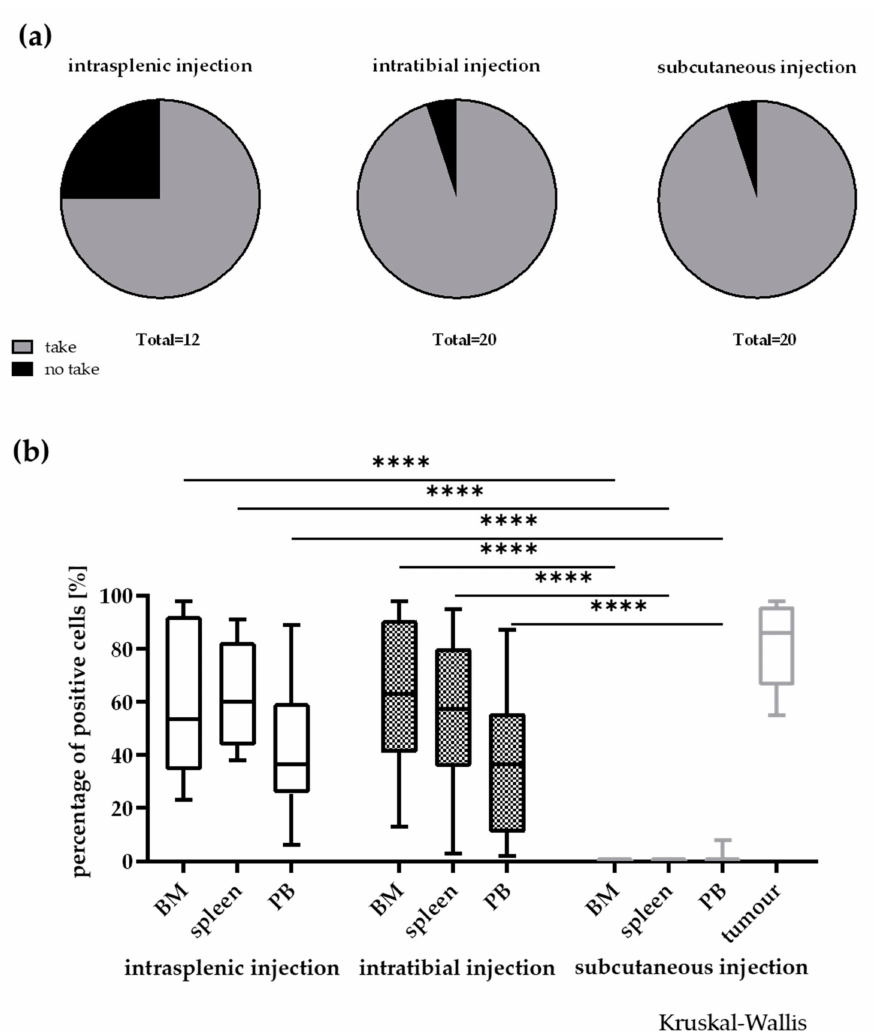
Figure 4. Influence of the injection site on take rate ( a ) and infiltration rate in di ff erent compartments ( b ) in 20 leukaemia PDX models. In general, the take rate was not influenced by the implantation site. Nevertheless, a few models did only engraft in two out of the three injection sites. A no take was defined by no growth after three individual experiments with n > 3 mice and an observation time > 2-fold of the passaging time of the individual model. **** p <